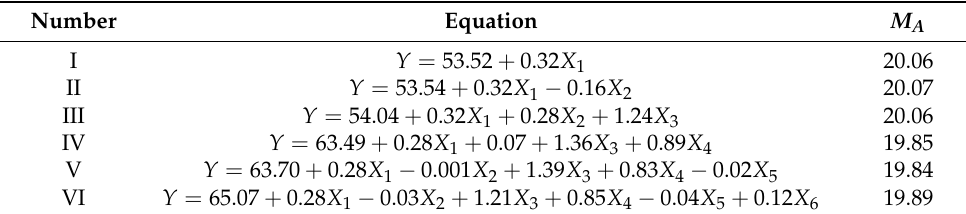
Table 4. Optimization equations of the Multiple Linear Regression.